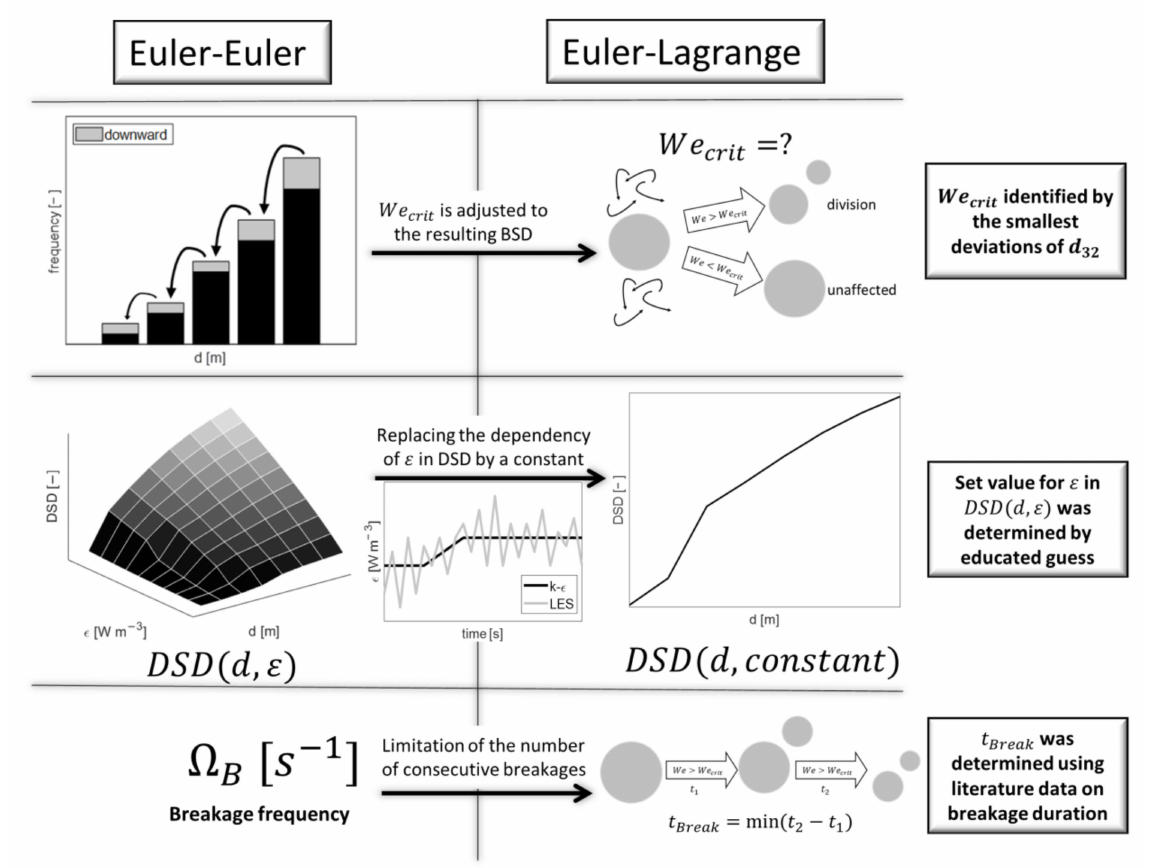
Figure 6. Overview of fitting parameters for the EL breakage model. The function, as well as the method for the determination of the parameters, is illustrated. The left column depicts the bubble breakage implementation in EE and the right column shows how the implementation is transferred into an EL implementation. ( Top left ): Different bubble sizes exist in a PBM solely as distribution quantities that shift into smaller classes in case of a breakage. ( Top right ): A breakage of an individual bubble is executed only if the breakage criterion in the form of We crit is exceeded. ( Center left ): The shape of the DSD changes three-dimensionally with varying bubble diameters and turbulent dissipation energy. ( Center right ): The shape of the DSD changes solely with varying bubble diameter and the influence of the turbulent dissipation energy is replaced by a constant. ( Bottom left ): The integro-differential equation of the PBM calculates bubble breakage events per unit of time. ( Bottom right ): After an executed bubble breakage, a subsequent division can take place at the earliest after the time t break